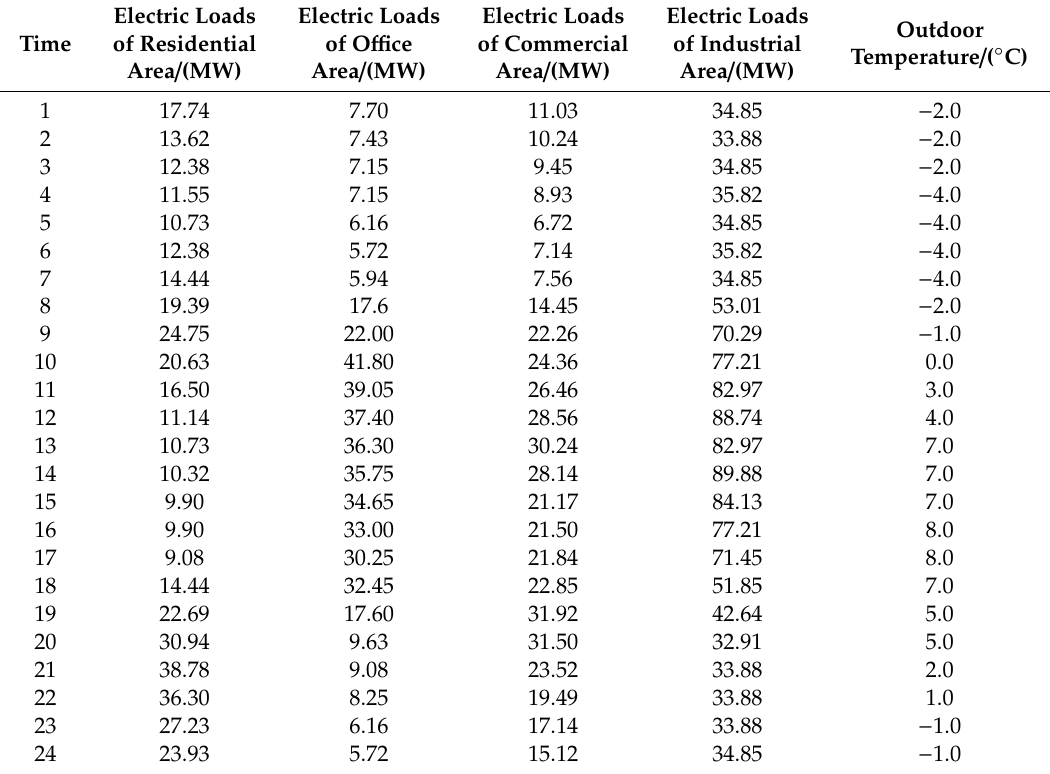
Table A8. Typical daily loads and outdoor temperature data of multiple functional areas in winter.